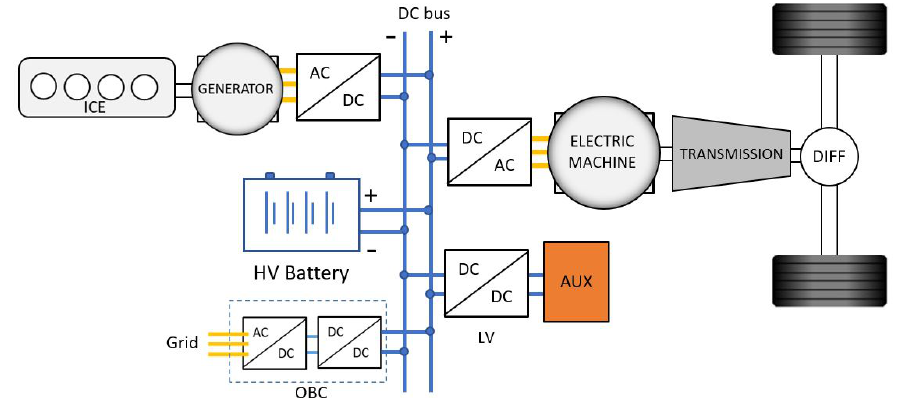
Figure 2. Plug-in series hybrid powertrain architecture used in the ZUEZ long-haul coach use